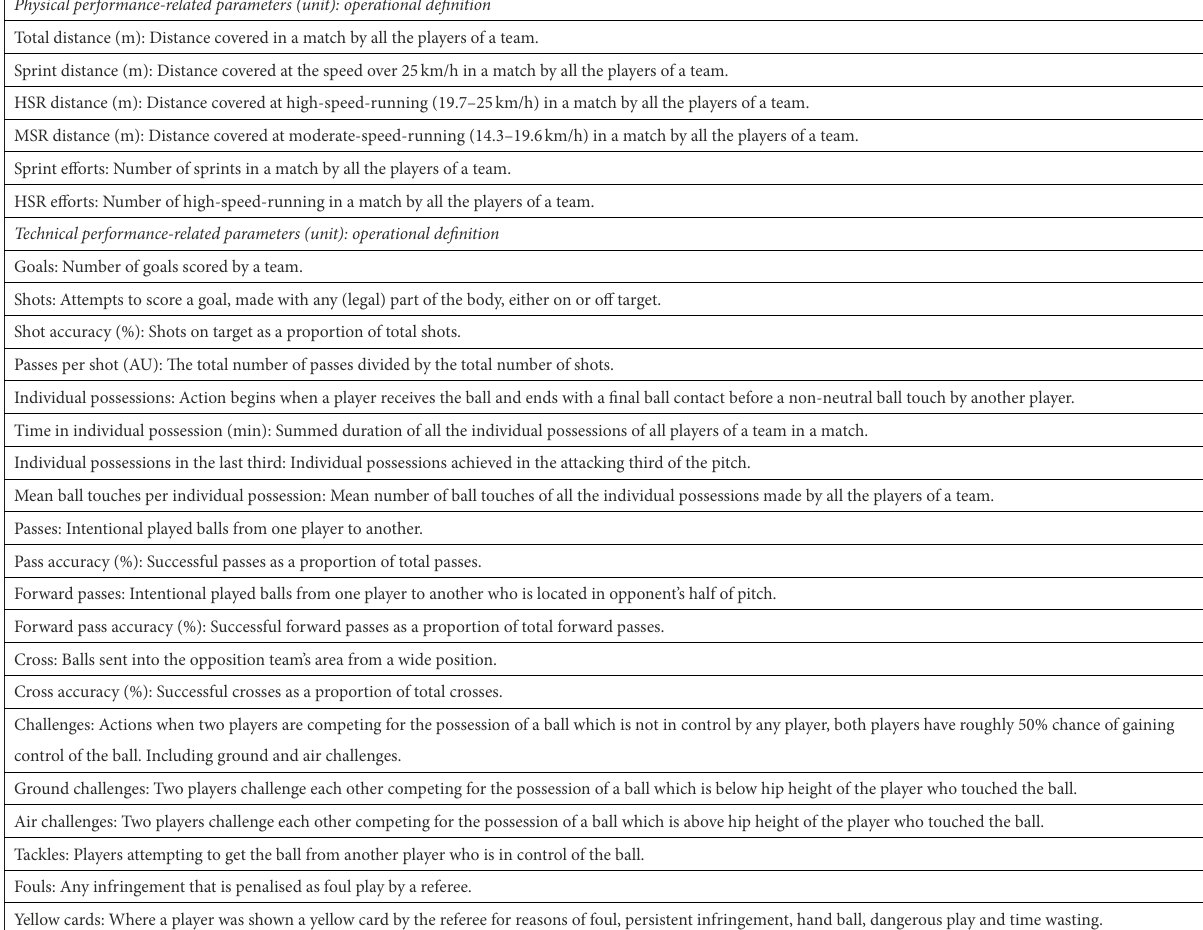
TABLE 1 Selected technical and physical performance-related parameters (dependent